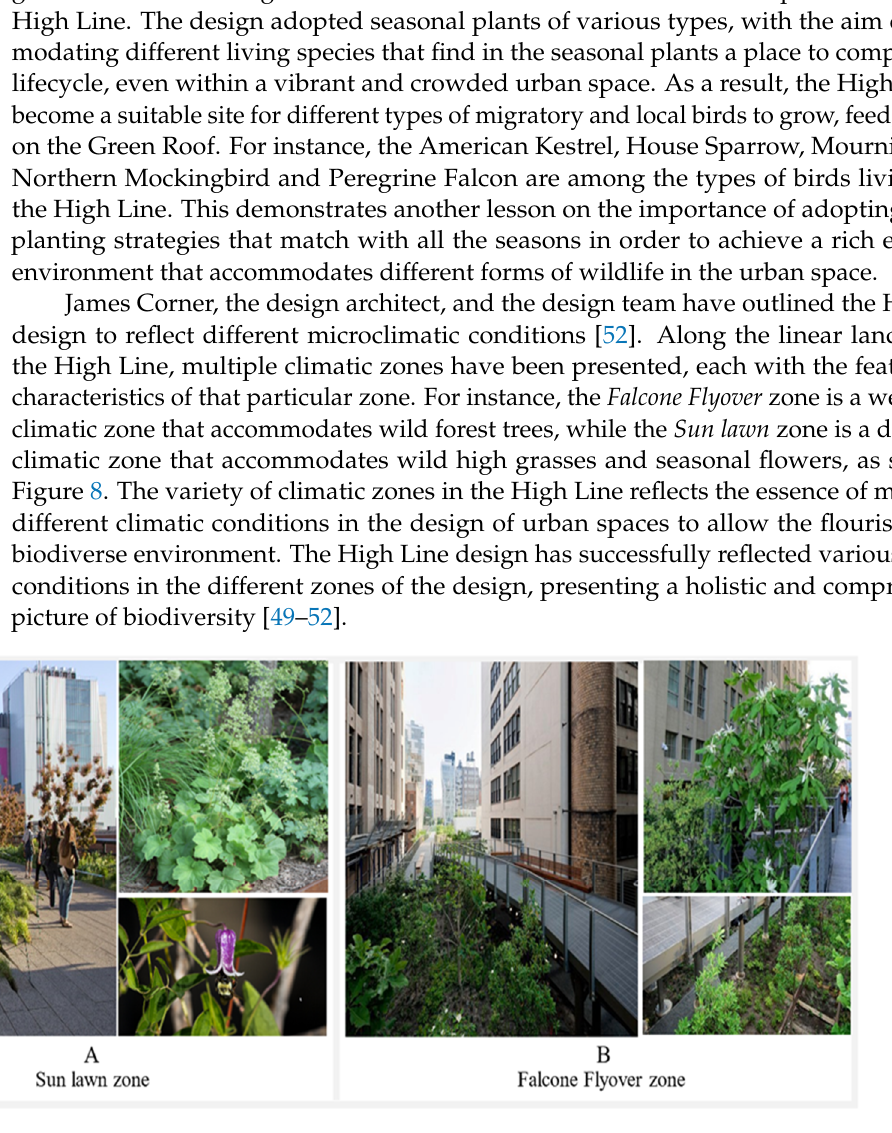
Figure 8. The High Line: ( A ) Sun Lawn Zone; ( B ) Falcone Flyover Zone. Data from source [49].